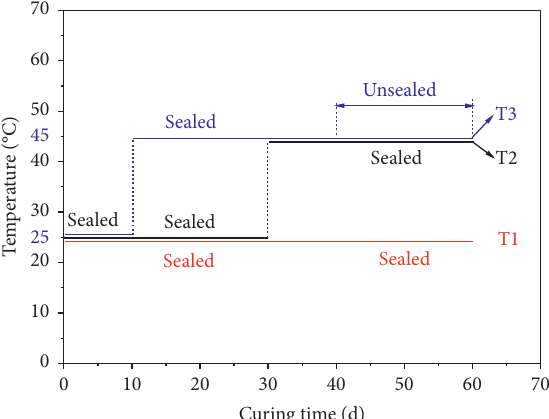
Figure 2: The designed curing conditions for AAFC incorporating